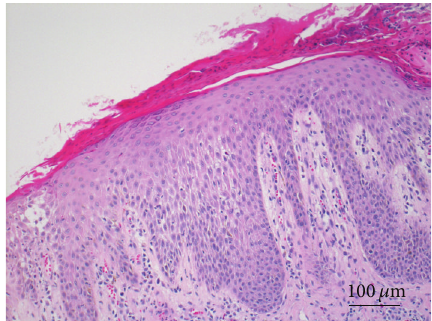
Figure 2: Microscopic features of the biopsied abdominal skin in case 1 (hematoxylin and eosin). The involved epidermis reveals reactive downward acanthosis with lymphocytic exocytosis and spongiotic reaction focally resulting in small vesicle formation. An eosinophilicmicroabscessisformedintheparakeratotichornylayer. The granular keratinocytes have disappeared. Superficial perivascu- lar infiltration of lymphocytes and eosinophils is